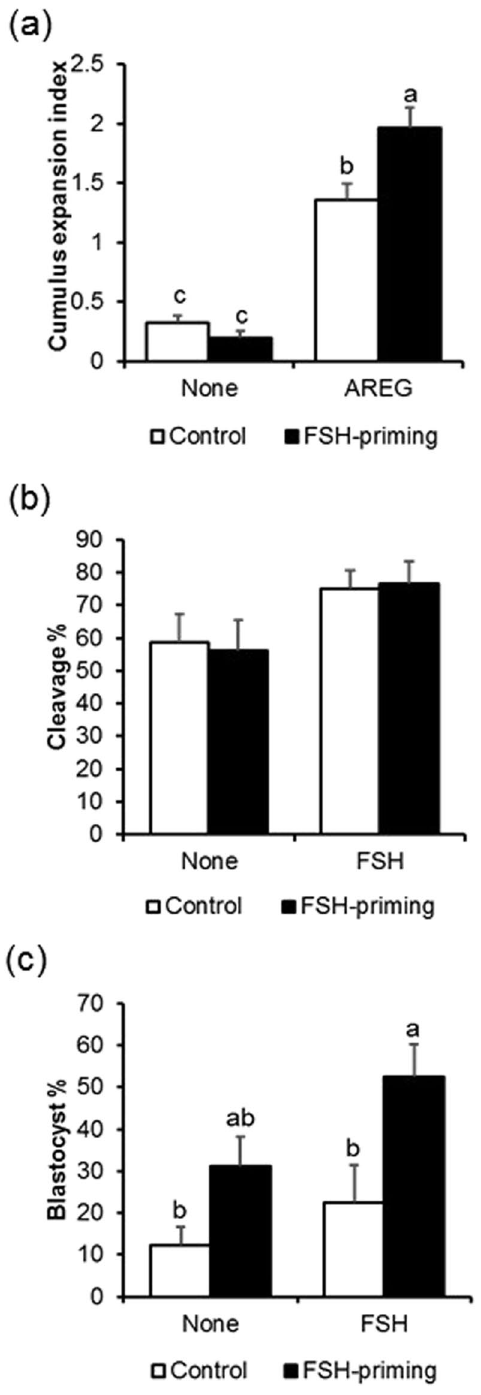
Figure 1. Extracellular expansion of the cumulus cells and developmental competence of oocytes from both unpriming and FSH priming cows. The cumulus expansion index of the COCs derived from donor cows without (control) or with FSH-priming, which were cultured without the ligand (none) or with amphiregulin (AREG), was examined at 22 h of oocyte maturation ( a ). Effect of FSH-priming prior to OPU and supplementation of FSH during in vitro maturation on oocyte developmental competence were examined by measuring the following on-time embryo development milestones; cleaved embryos at day 2 ( b ) and blastocyst development on day 7 ( c